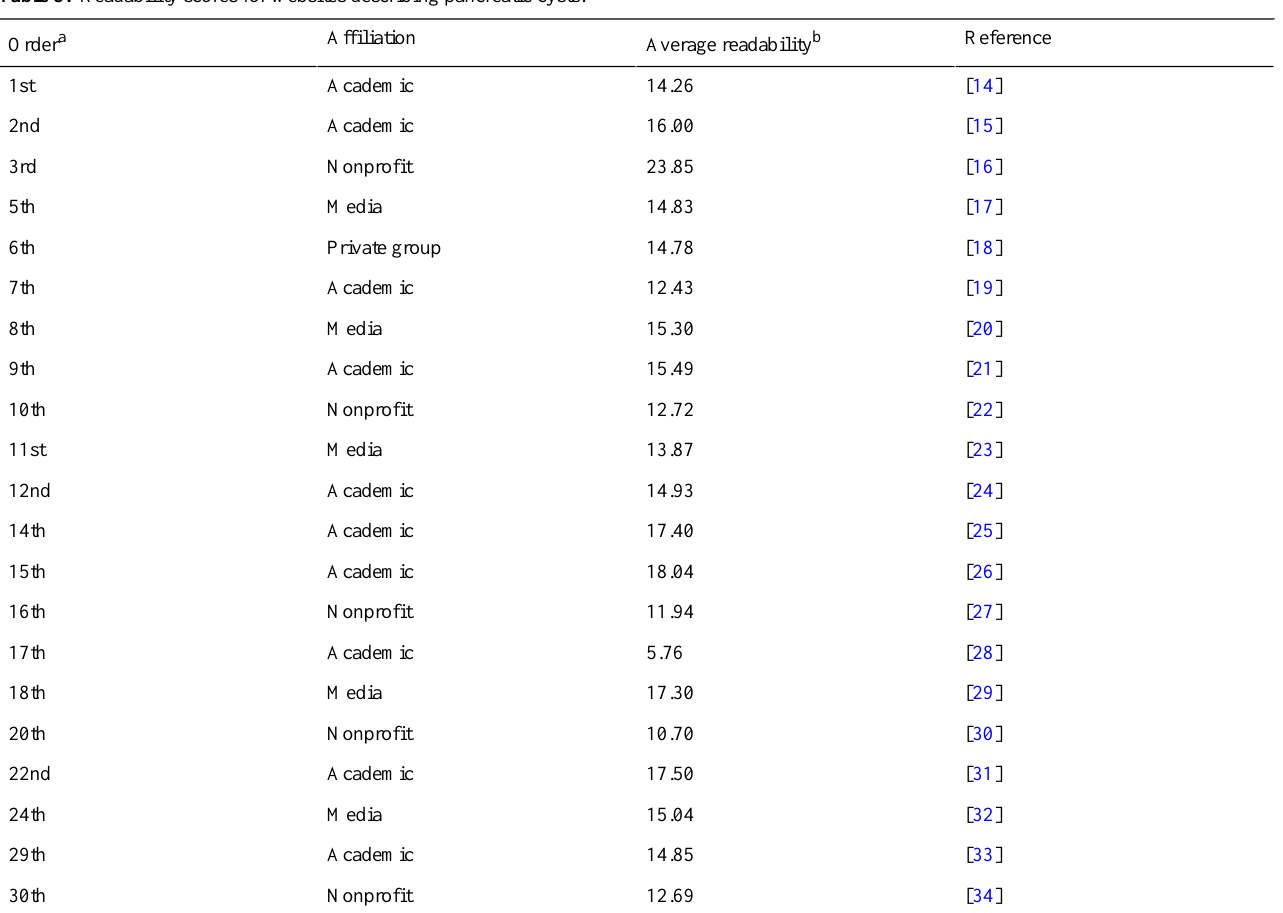
Table 3. Readability scores for websites describing pancreatic